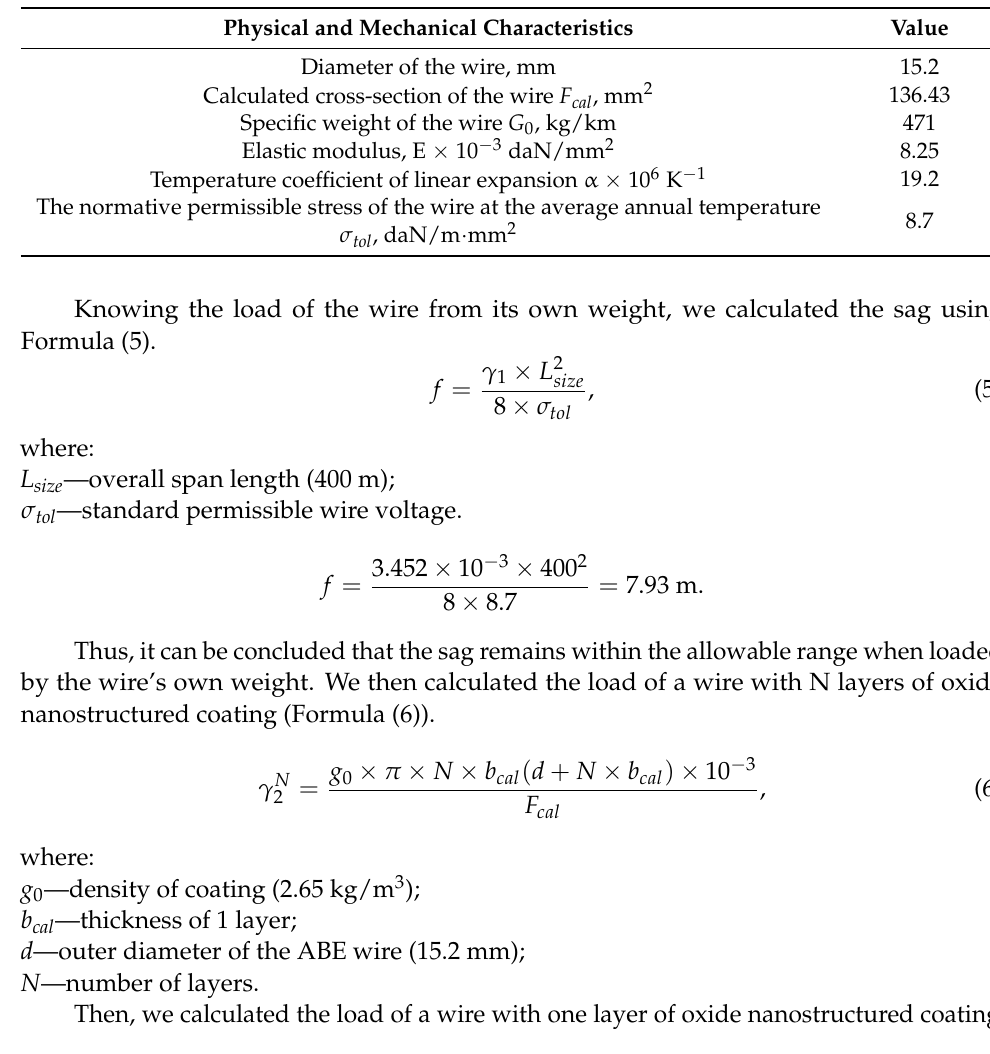
Table 9. Physical and mechanical characteristics of the ABE